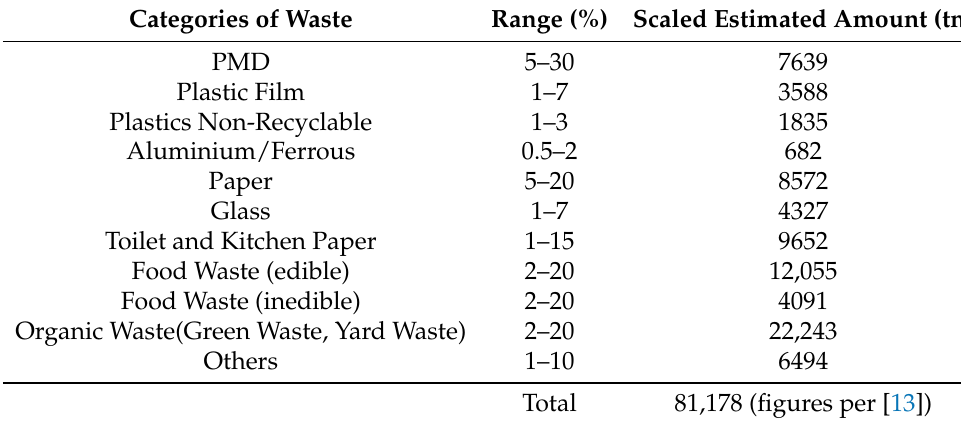
Table 2. Waste Compositional Analysis categories, percent relative range and scaled amount of Waste for the virtual